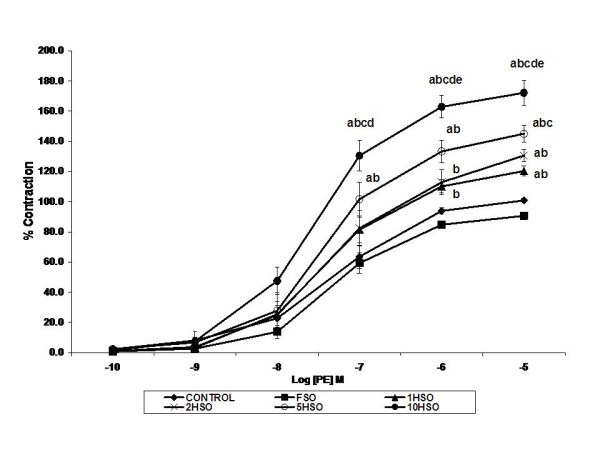
Effects of fresh and heated soy oil on vascular contraction in aortic rings. Shown are the contraction induced by phenylephrine (PE) in aortic rings isolated from rats fed with basal diet (control), fresh soy oil (FSO), soy oil heated once (1HSO), soy oil heated twice (2HSO), soy oil heated five times (5HSO) or soy oil heated ten times (10HSO) at different concentrations. Values are expressed as means ± S.E.M. (n = 7), p < 0.05 indicates significant difference compared to acontrol, bFSO group, c1HSO group, d2HSO group, e5HSO group.